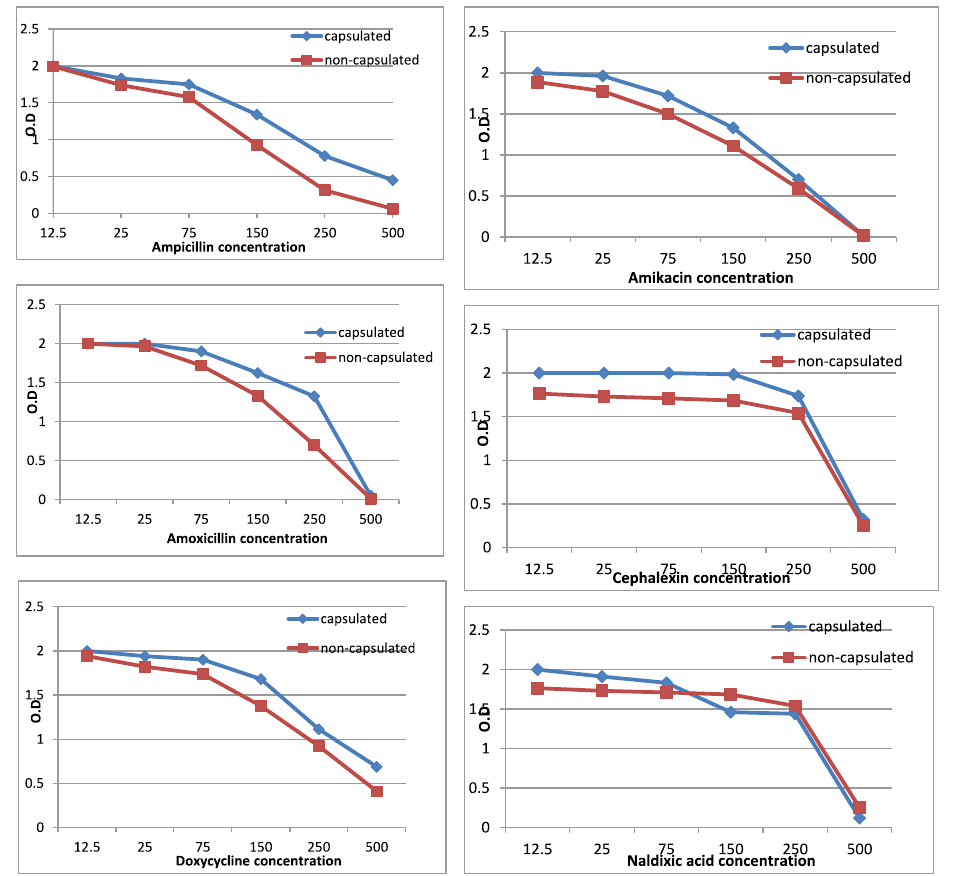
Fig. 6. Changes in growth of capsulated and non-capsulated K. ozaenae isolates at different antibiotics